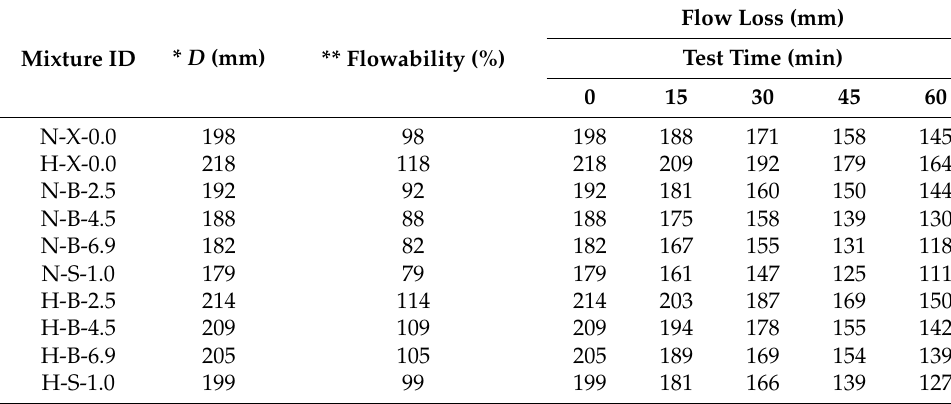
Table 4. Fresh properties of the cementitious